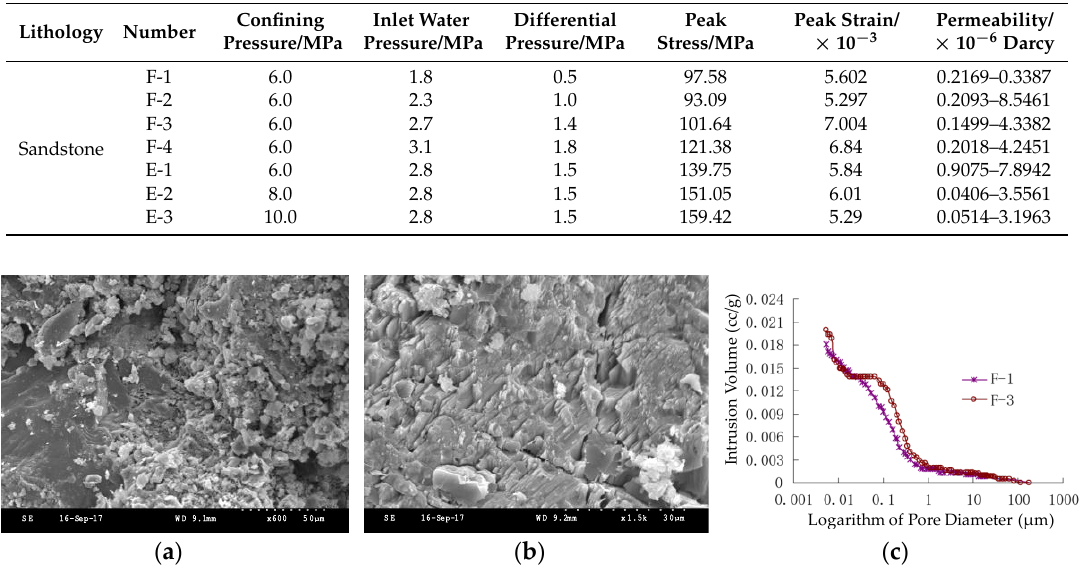
Table 1. Some test conditions and parameters.